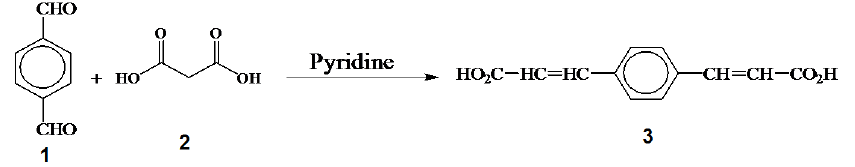
Figure 1. Scheme 1 of synthetic route of para phenylenediacrylic acid 3.